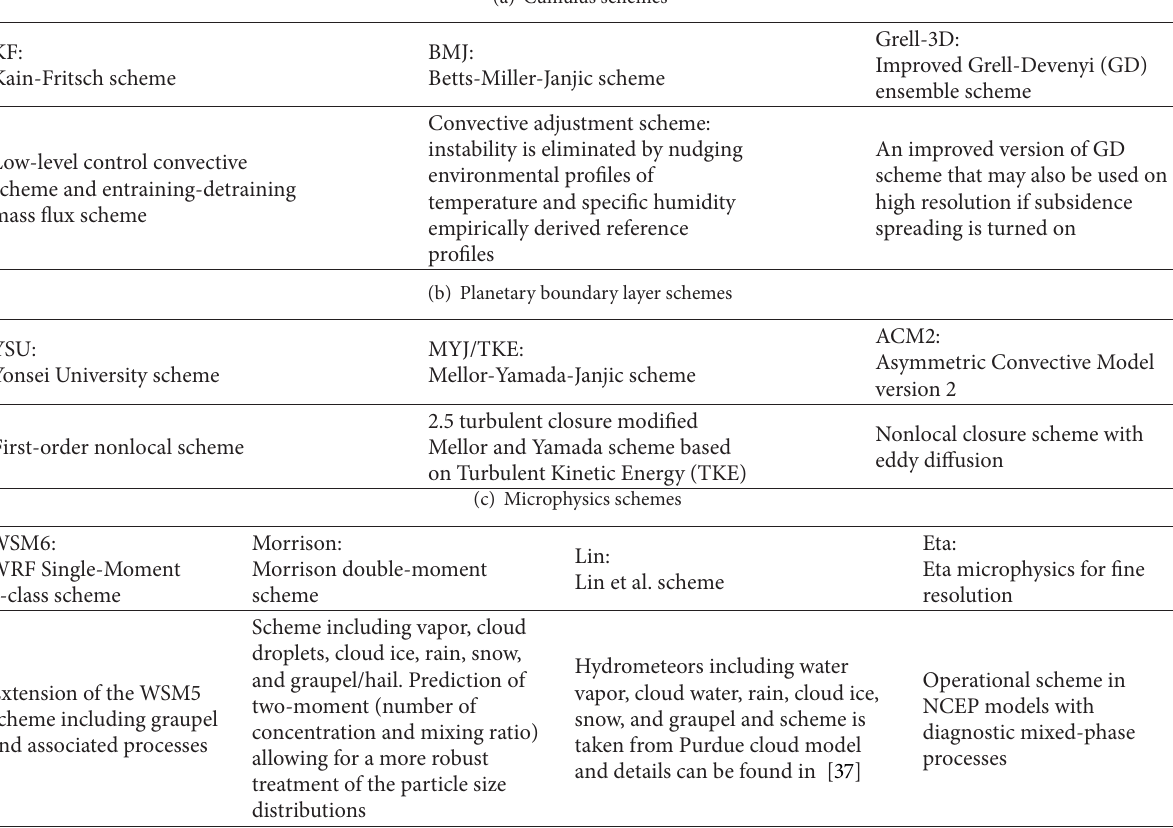
Table 1: Summary of cumulus, planetary boundary layer, and microphysics parameterization schemes used in this